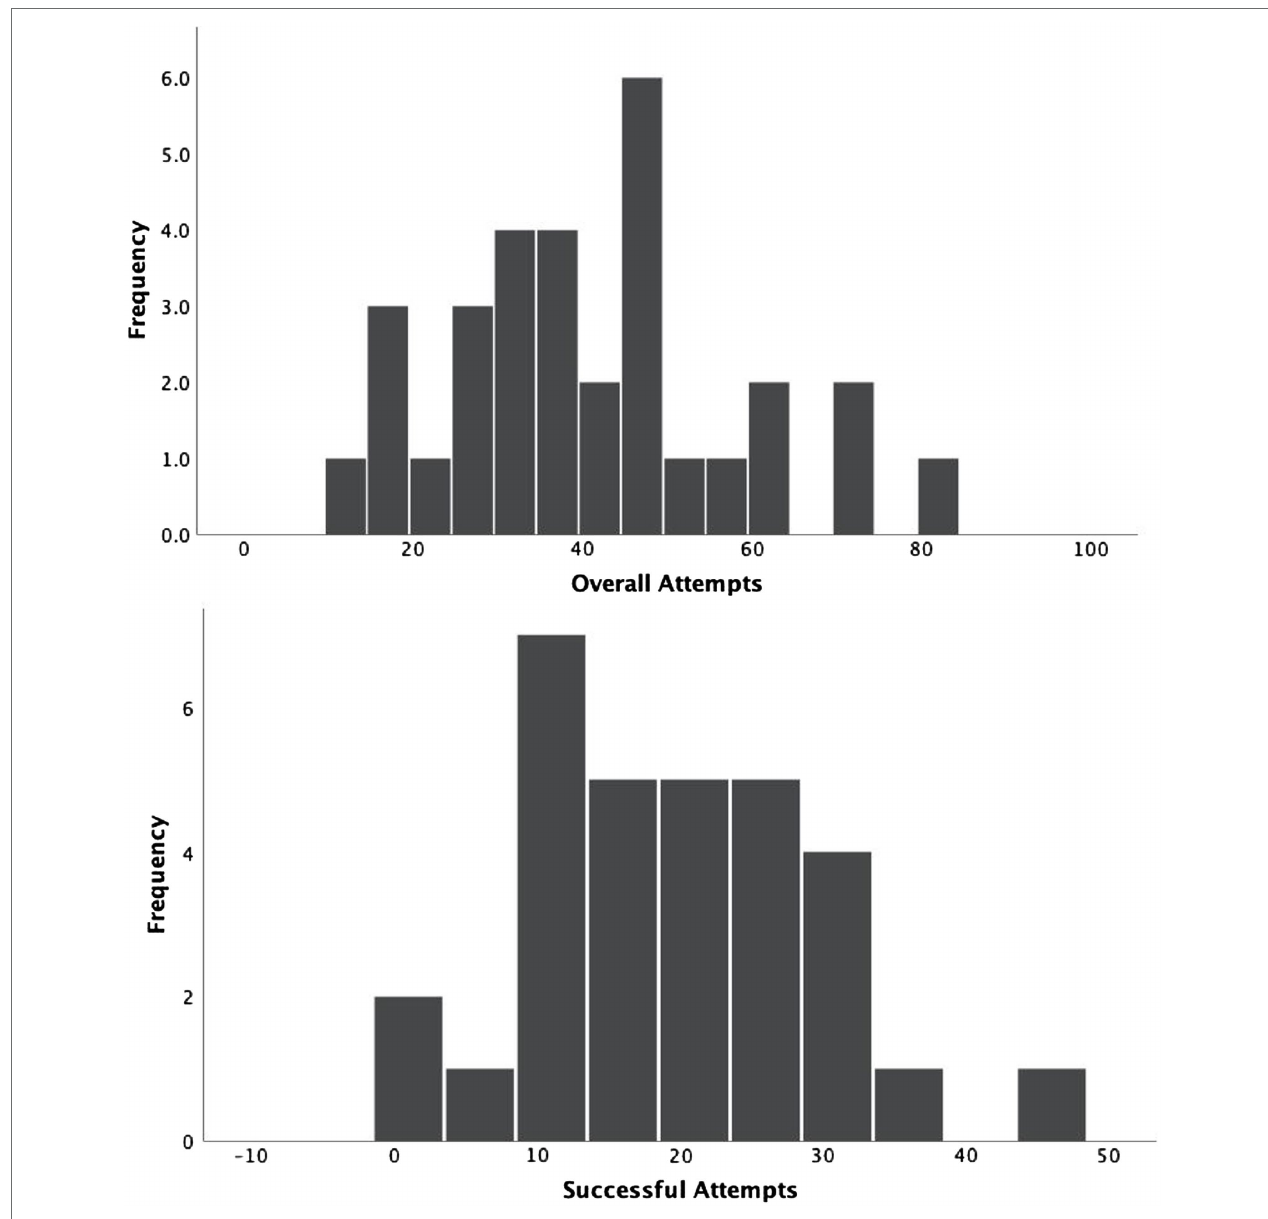
FIGURE 5 | Distribution of children’s